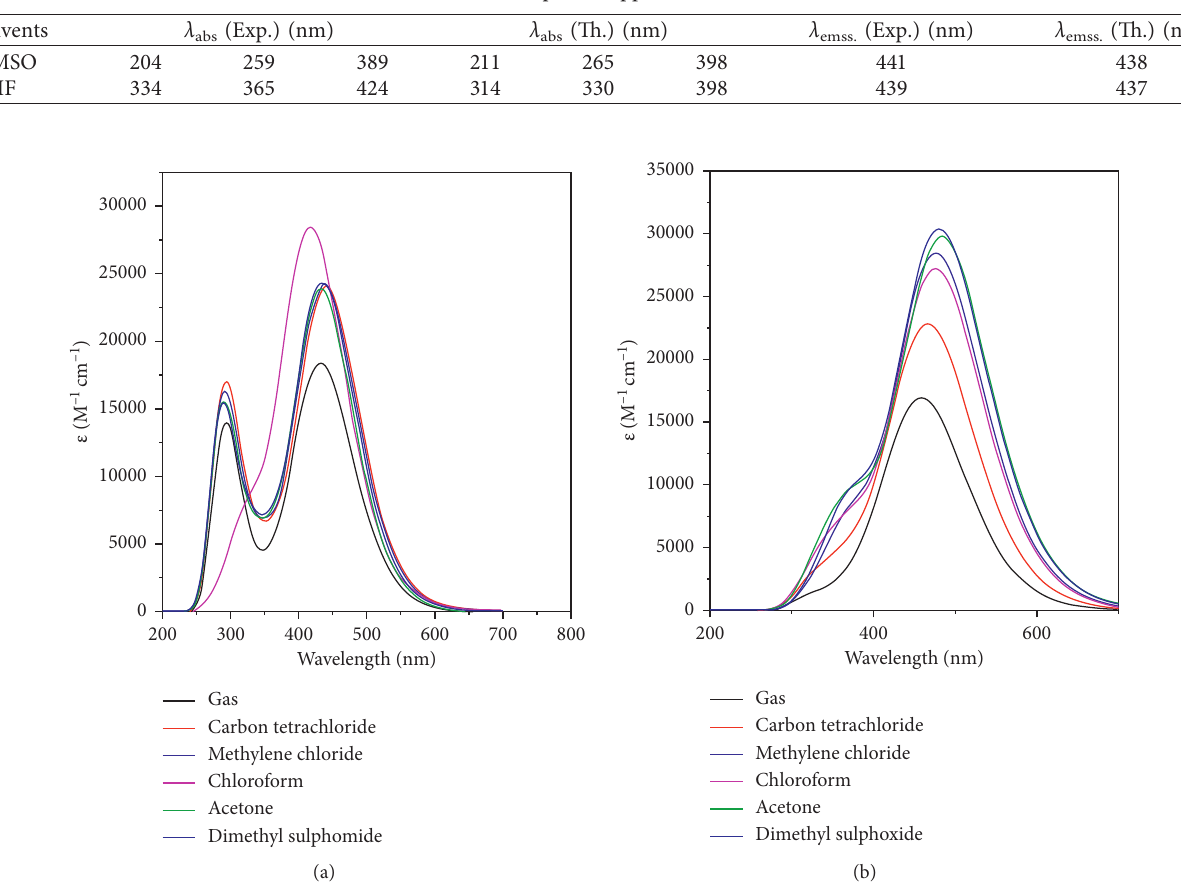
abs ) and emission ( λ emss. ) wavelengths for the DDP molecule